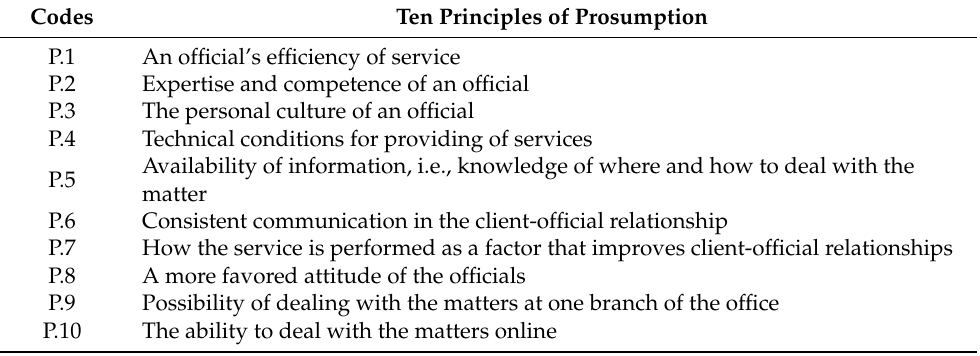
Table 1. The principles of